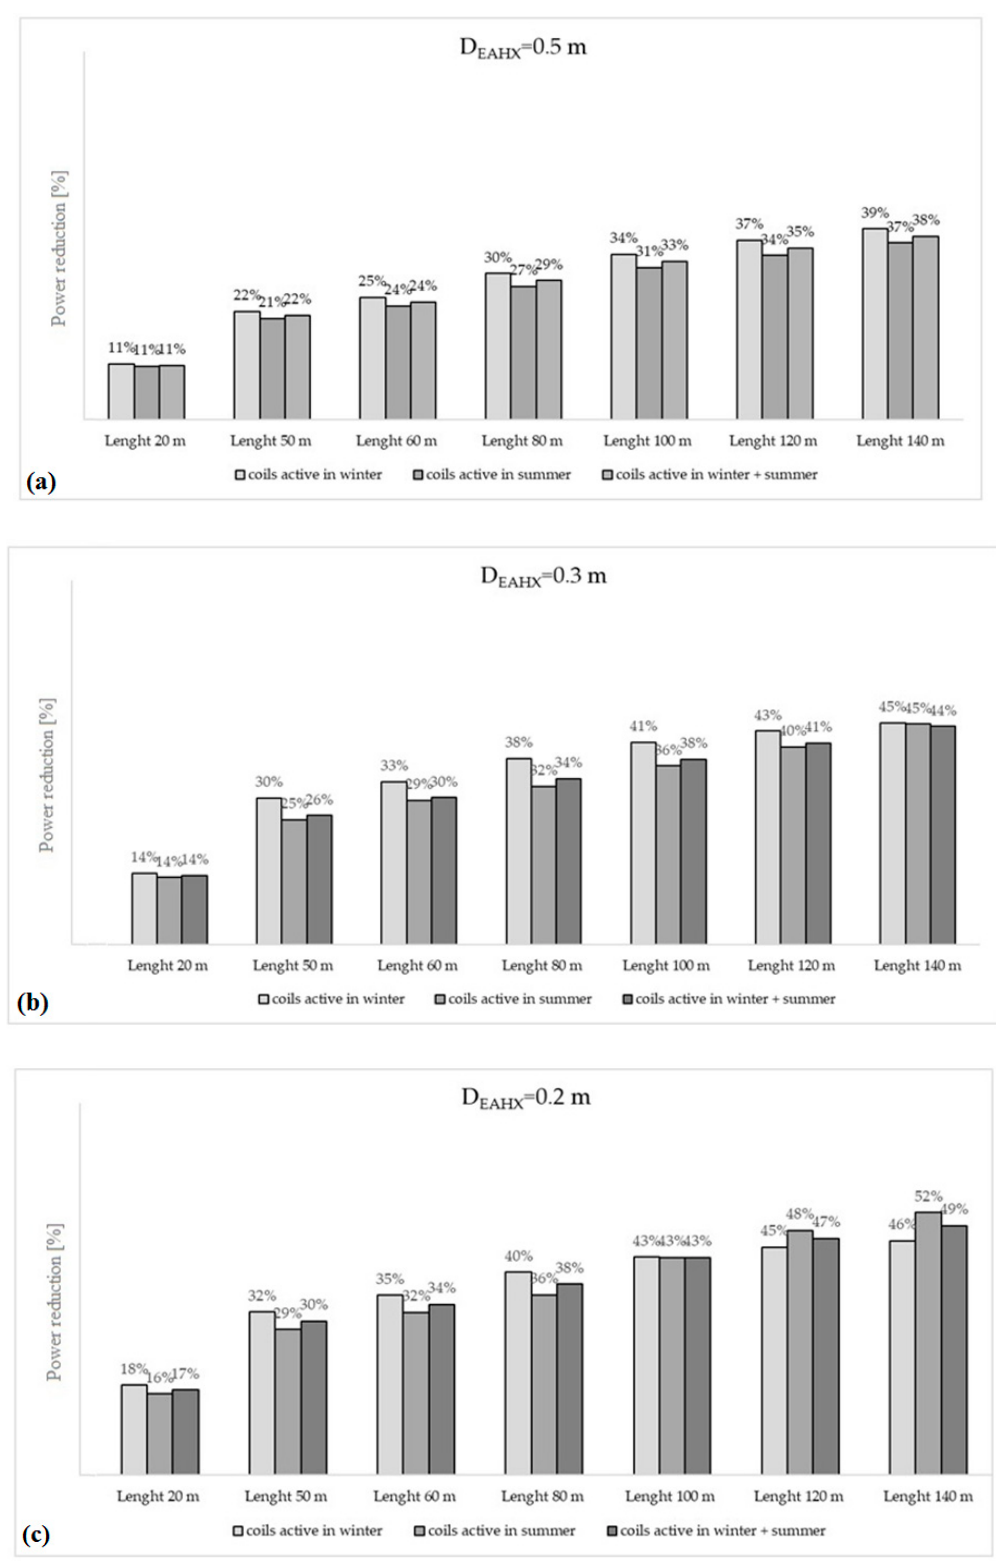
Figure 12. Percentage reduction of power AHU coils for different lengths of the EAHX and ( a ) D EAHX = 0.3 m, ( c ) D = 0.2 = 0.5 m, ( b ) D EAHX = 0.3 m, ( c ) D EAHX = 0.2 m . = 0.5 m, ( b ) D EAHX EAHX